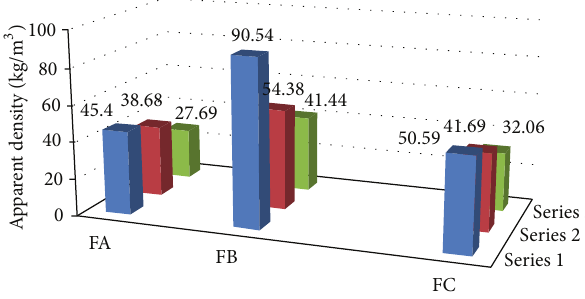
Figure 1: Apparent density of polyurethane